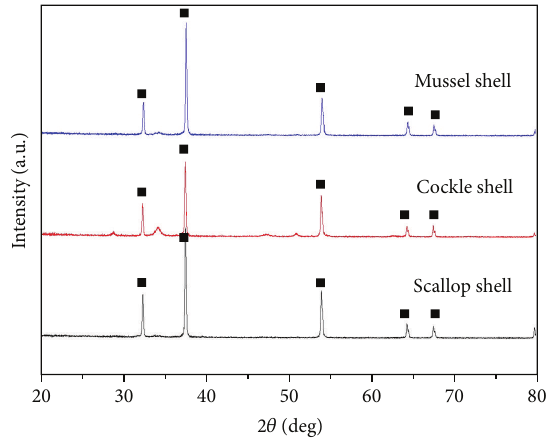
Figure 2: XRD patterns of natural and calcined mussel shell ( ◻ : CaCO 3 , ◼ : CaO).